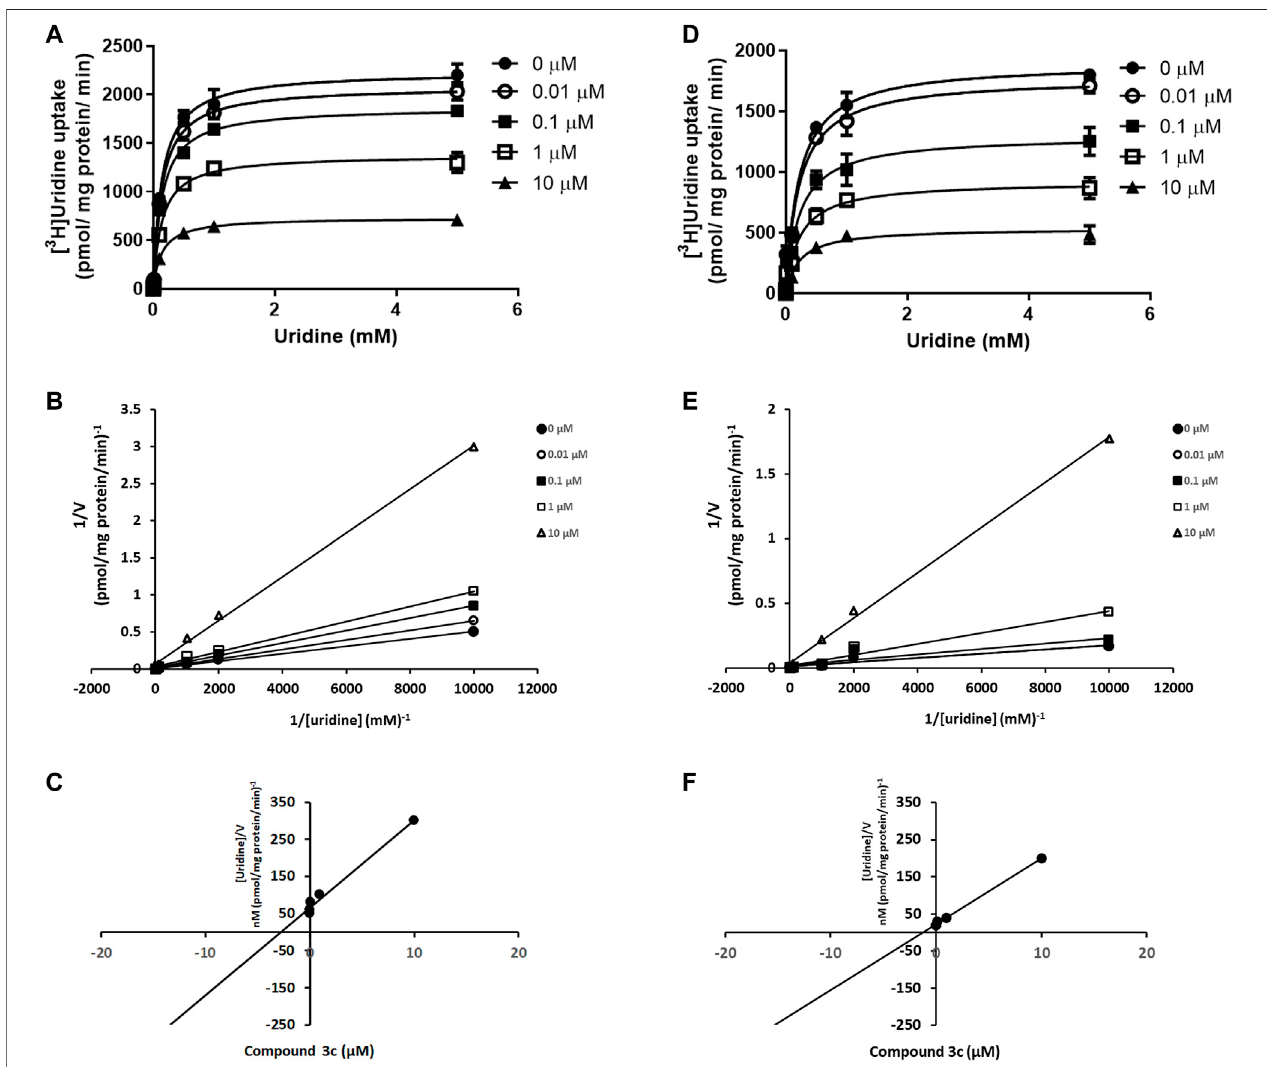
FIGURE 4 | Competitive inhibition of ENT1 and ENT2 by compound 3c. Kinetic study of [ 3 H]uridine uptake (0.1 μ M – 1 mM) was measured in (A) PK15NTD/ENT1 and (D) PK15NTD/ENT2cellsinthepresenceofvariousconcentrationsofcompound 3c (0,0.01,0.1,1and10 µM) (B,E) 1/ V versus1/[S]plotsofeachcurvein (A) and (D) , respectively (C,F) The plot of slopes of each line in (B) and (E) , respectively, versus the concentration of compound 3c . Data are presented as mean ± SE of three experiments.